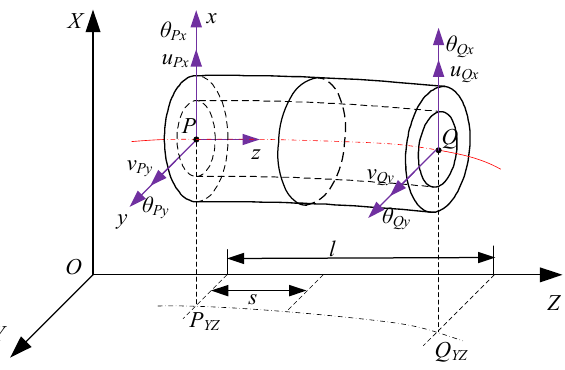
Figure 4. Cylindrical shaft beam element.